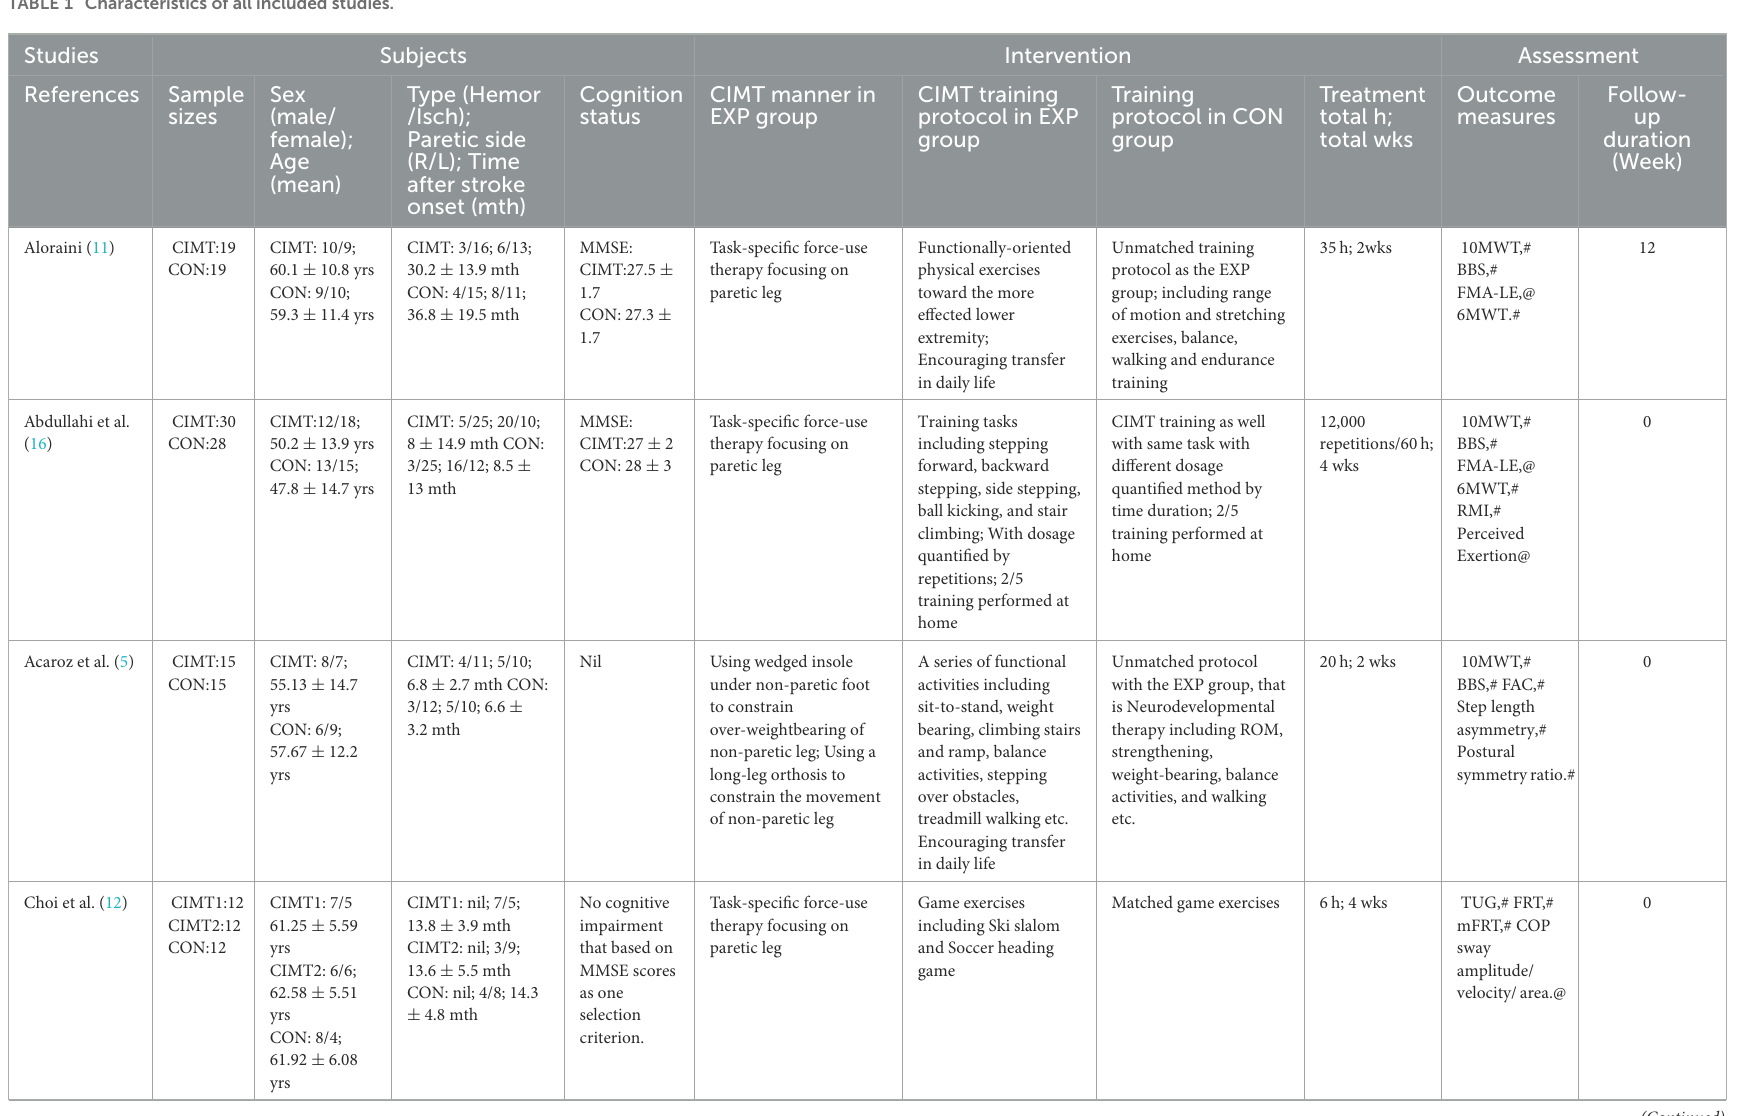
TABLE 1 Characteristics of all included